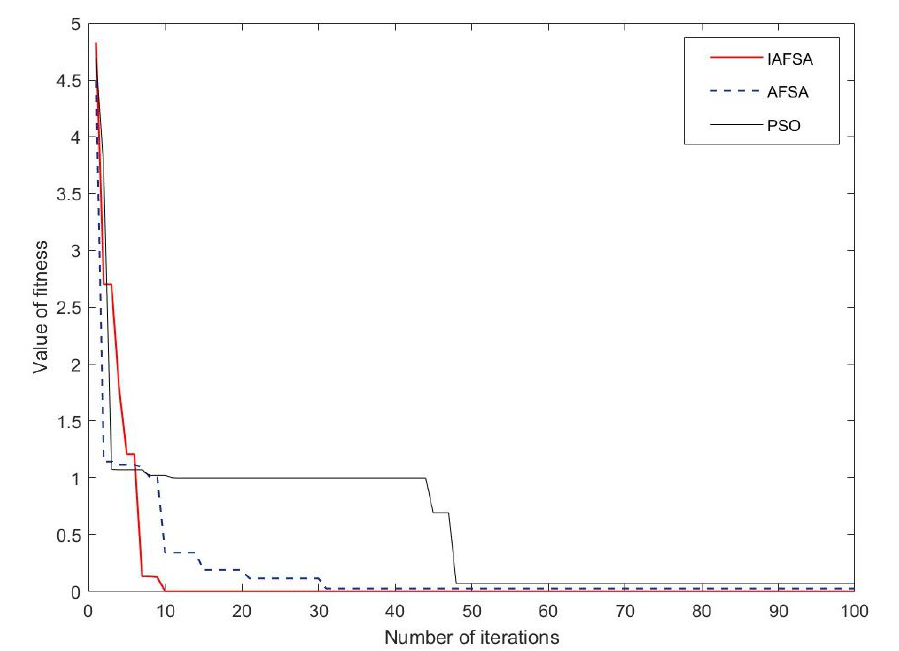
Figure 6. Convergence curve of test function F 12